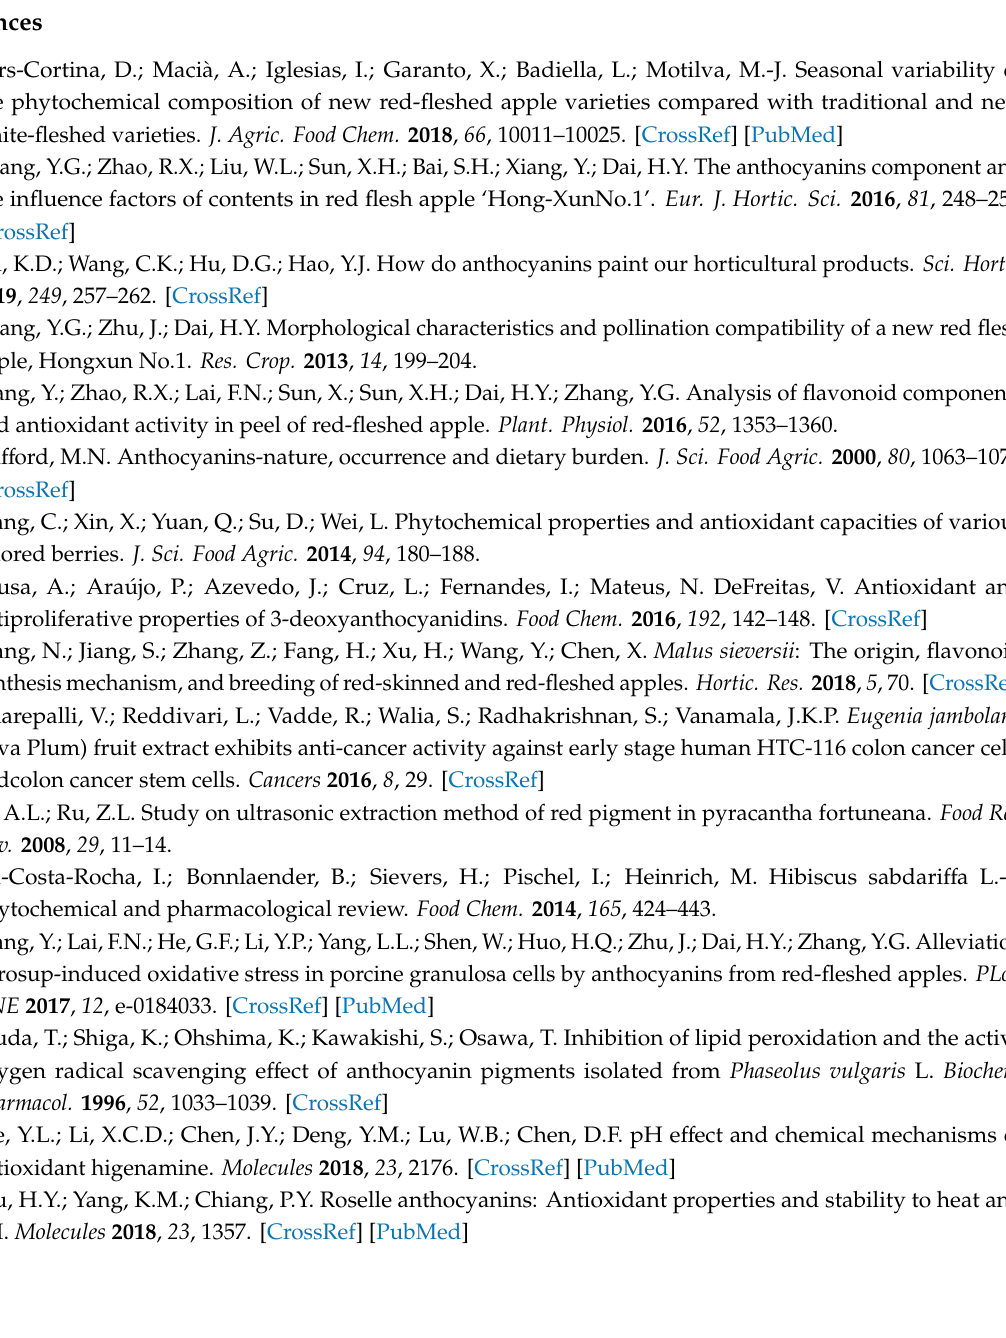
Supplementary Materials: The following are available online, Table S1: Extremely significant di ff erential metabolite compounds between RL and